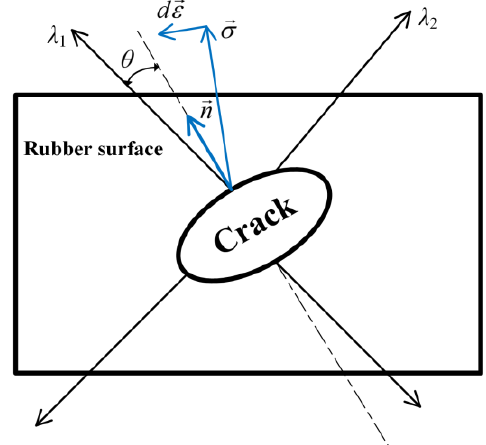
Figure 2. Stress state of rubber fatigue crack.